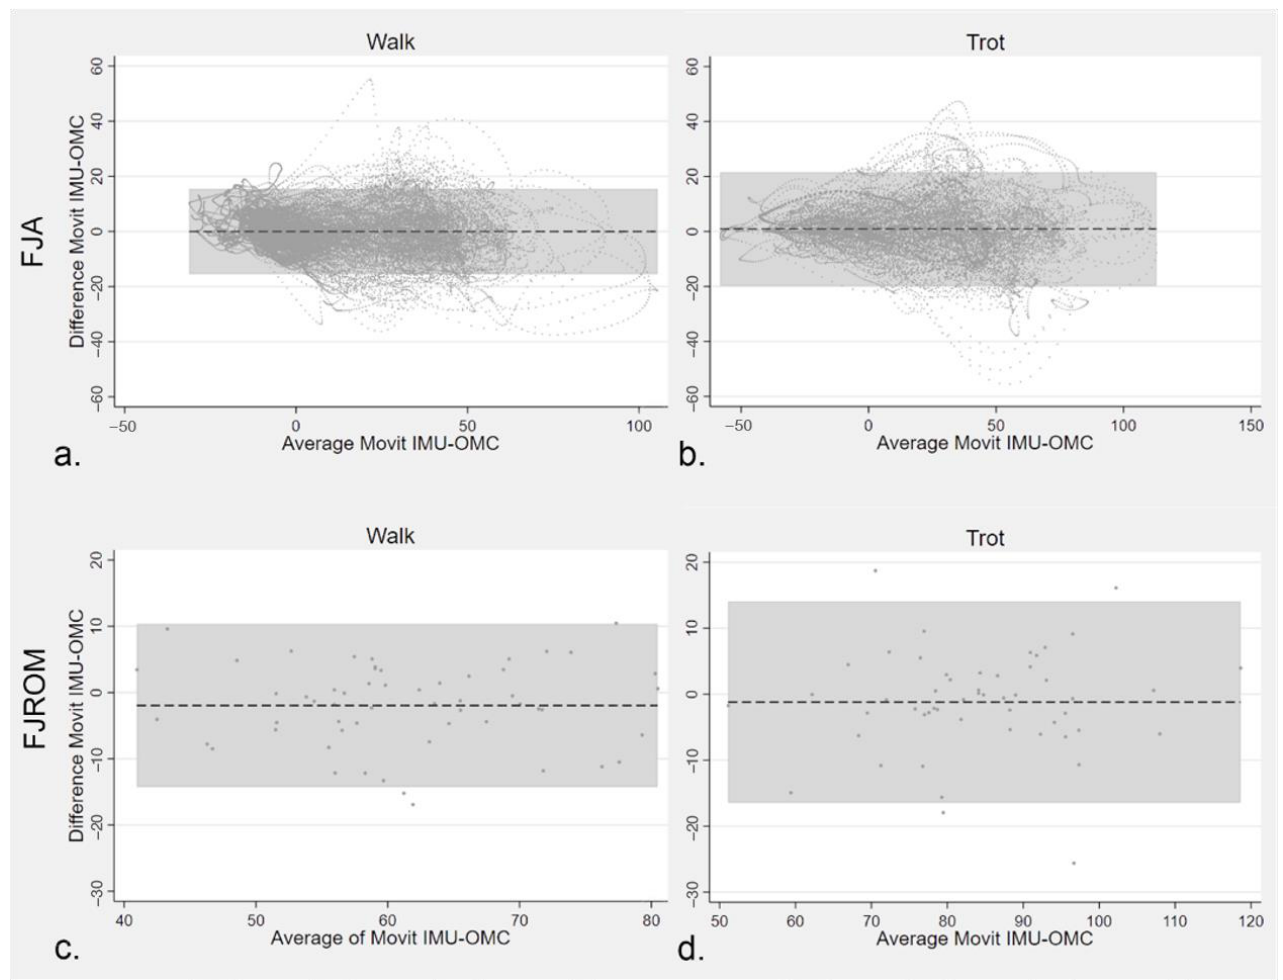
Figure 10. Bland – Altman plots indicating agreement between MOVIT IMU system and 2-D OMC concerning FJA ( a , b ) sampled at 200 HZ and derived FJROM ( c , d ). Data were obtained at walk (( a , c ) respectively with n = 389,377 and n = 14) and at trot (( b , d ) respectively with n = 16,333 and n = 13). Dashed horizontal lines show the mean differences between measures taken with the IMU and OMC technology. The grey areas indicate a 95% CI of the differences.